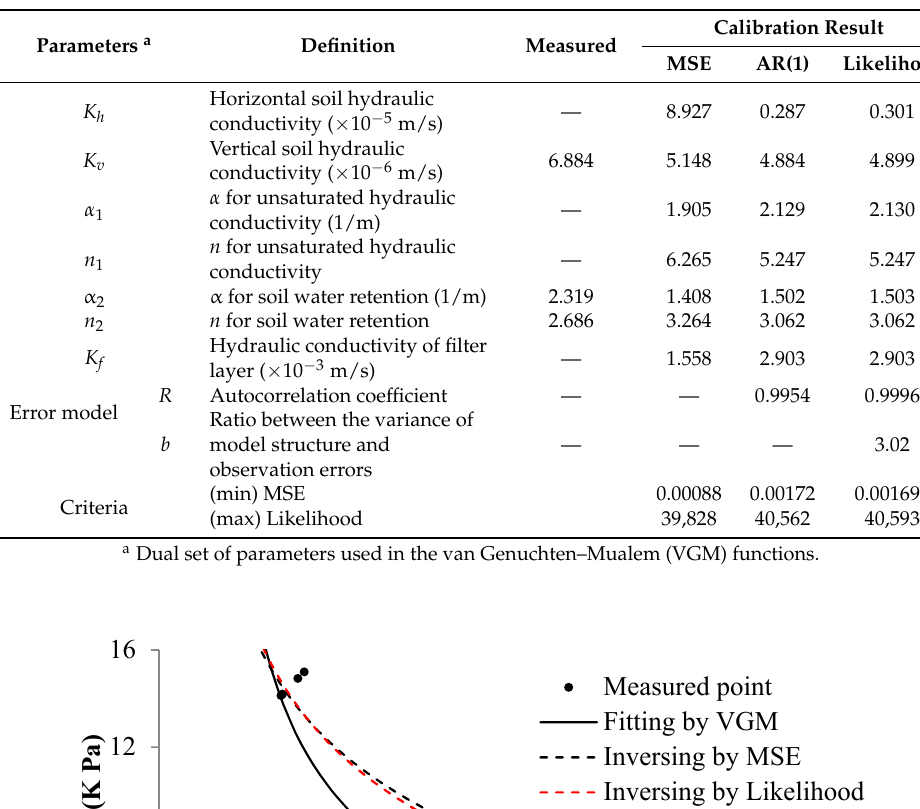
Table 3. Description of model parameters with measured values and optimized results.